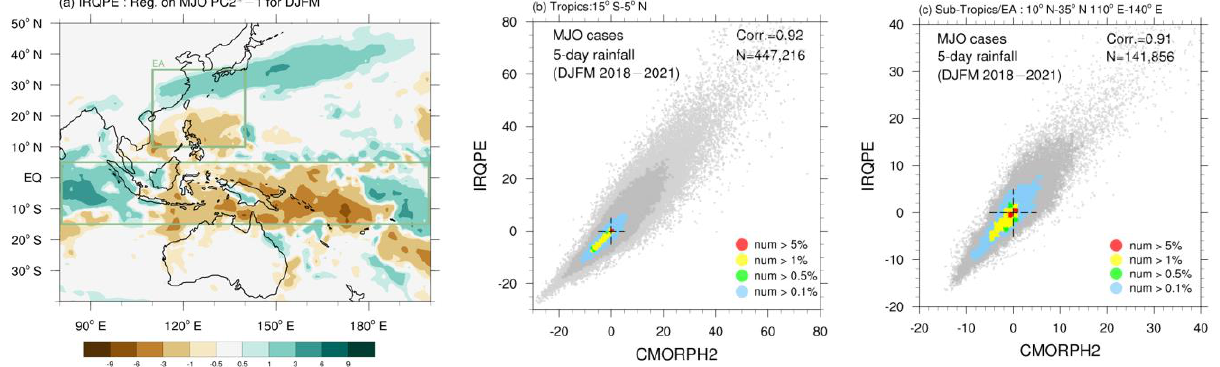
Figure 7. IRQPE application for MJO. ( a ) IRQPE regresses on MJO PC2 for DJFM season on a 5-day basis. ( b , c ) The point-to-point scatter plot from IRQPE and CMORPH2 for MJO days over Tropics and EA region (shown in ( a )).